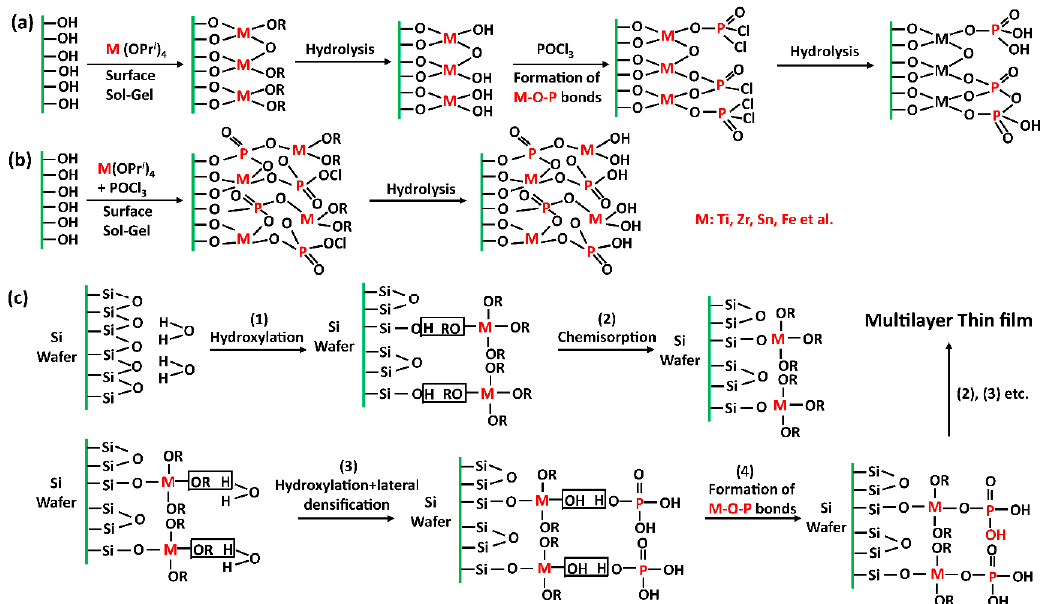
Figure 1. ( a ) Modification of SBA-15 surfaces by alternate grafting with M (OPri) 4 and POCl 3 (Method 1); ( b ) modification of SBA-15 surfaces by one-pot grafting of metal phosphate formed in situ (Method 2); and ( c ) principle of a sequential deposition of a metal phosphate [31].